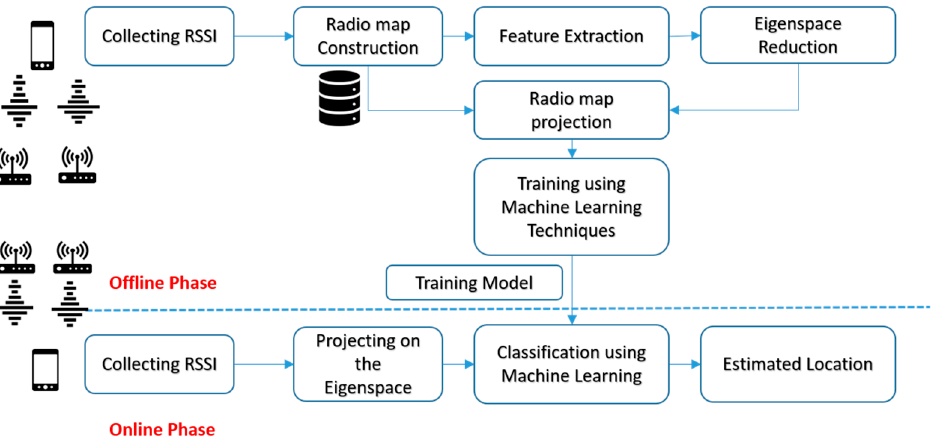
Figure 1. Proposed System Architecture.